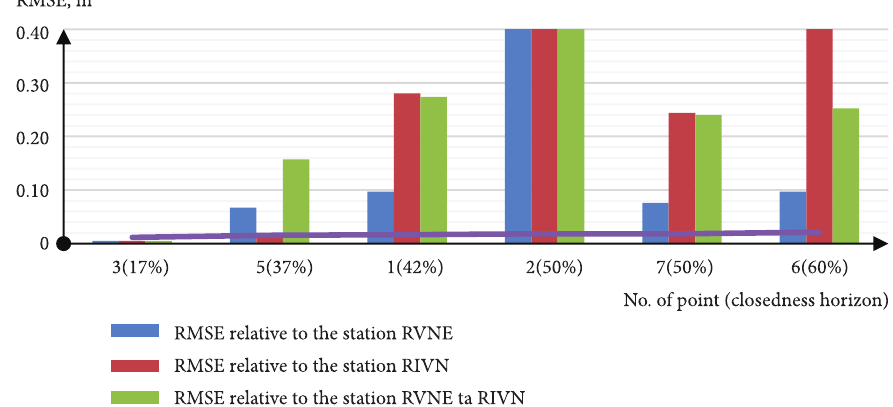
Figure 3. Comparison of RMSE of the spatial location by the session duration for 1 hour without executing the preliminary planning and prognostic points of accuracy evaluation calculated by Equation (7)